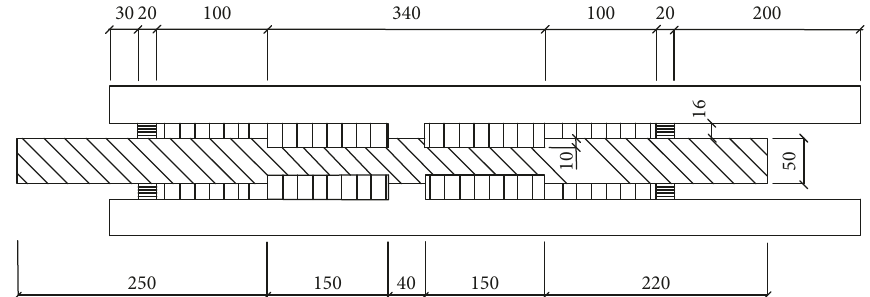
Figure 9: Detail drawing of ILSD-LS (Unit: mm).